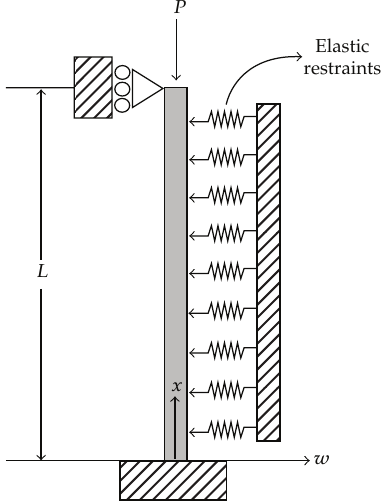
Figure 1: Column with continuous elastic